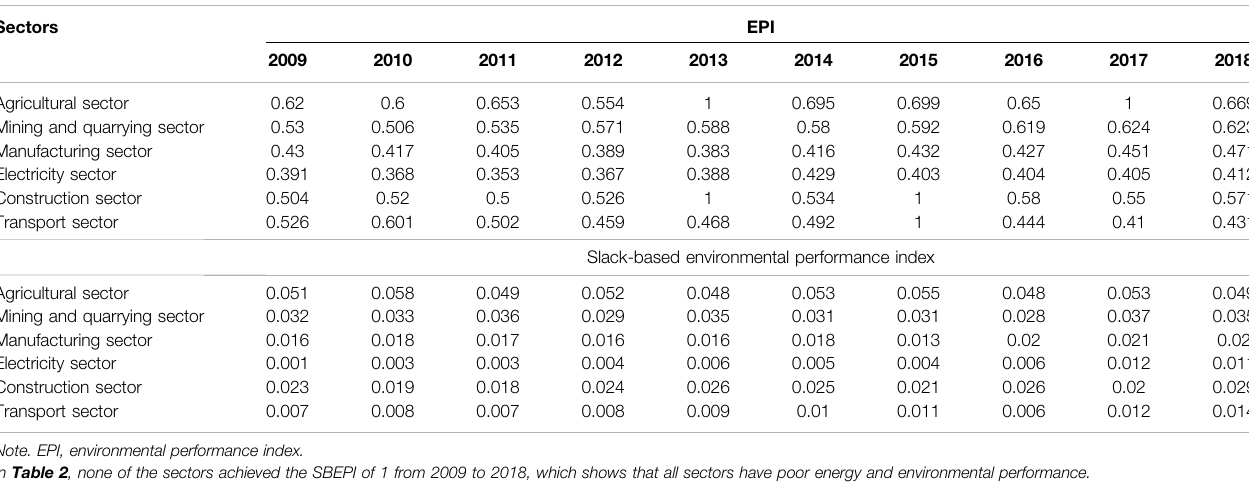
TABLE 2 | EPI and SBEPI scores within 2009 – 2018.